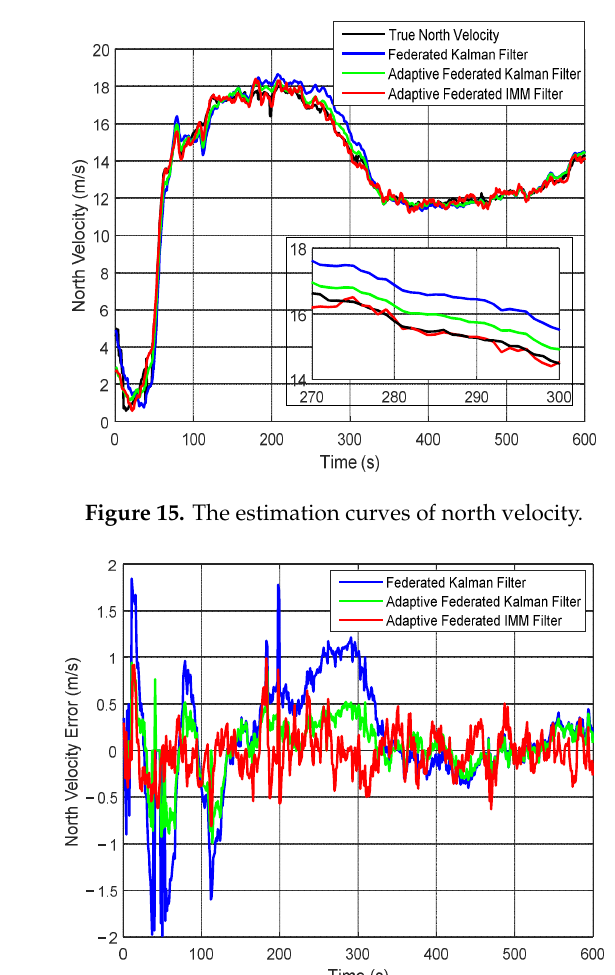
Figure 17. The estimation curves of latitude.